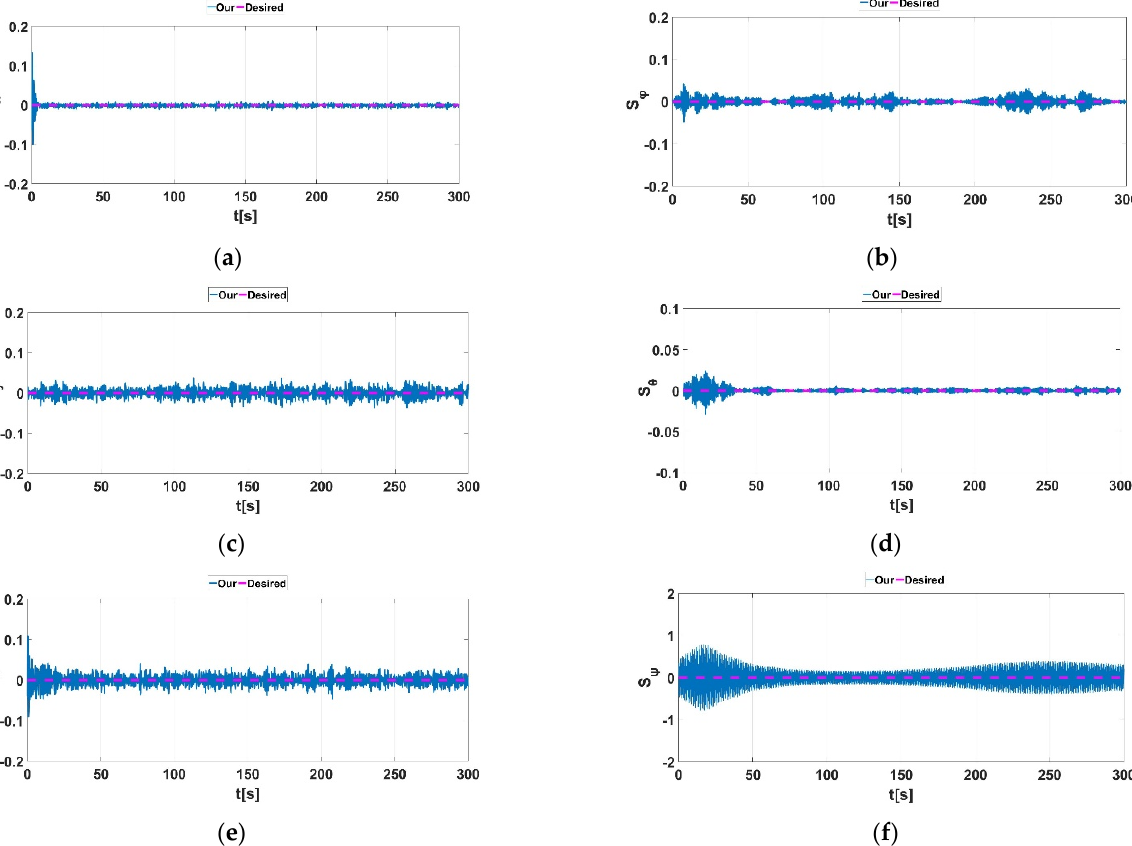
Figure 14. Inner − loop PID sliding surface 𝑺 𝑃𝐼𝐷 . ( a ) 𝑆 𝑥 ; ( b ) 𝑆 𝜑 ; ( c ) 𝑆 𝑦 ; ( d ) 𝑆 𝜃 ; ( e ) 𝑆 𝑧 ; ( f ) 𝑆 𝜓 .